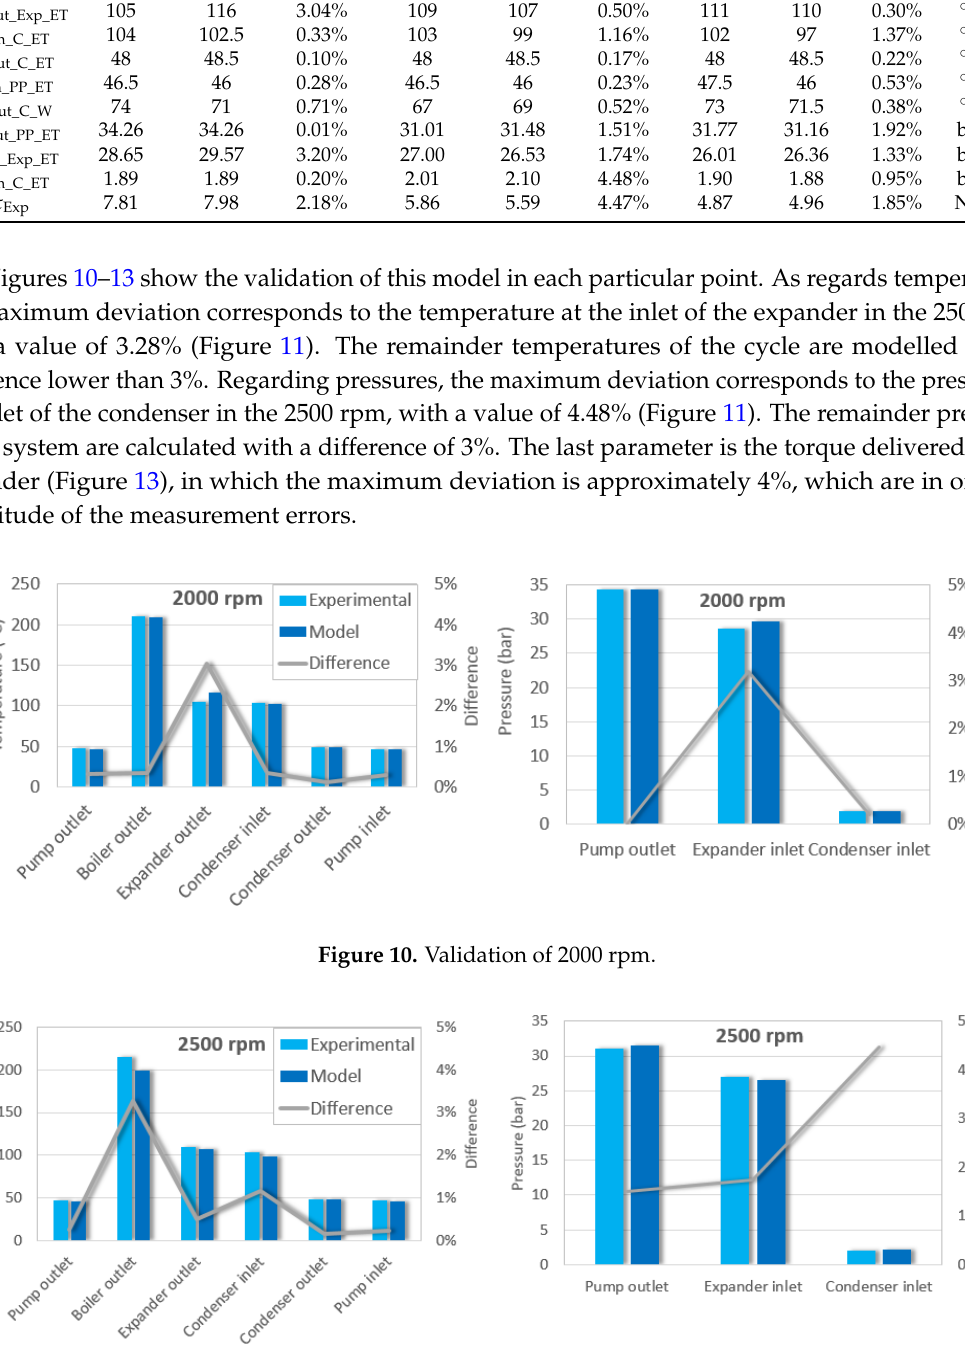
Figure 11. Validation of 2500 rpm.